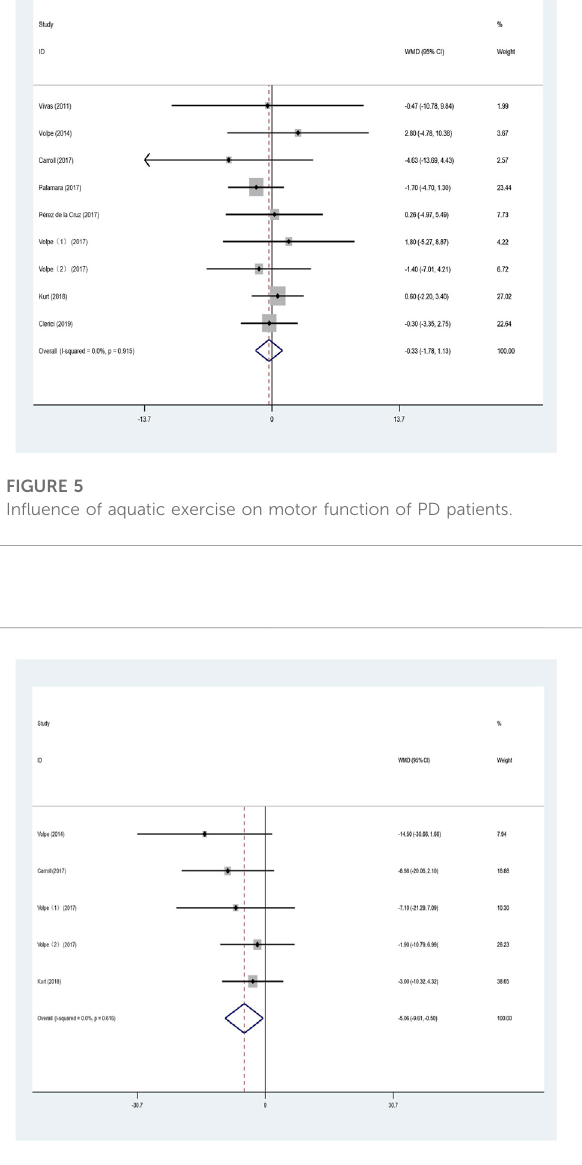
FIGURE 6 Effects of aquatic exercise on quality of life of PD